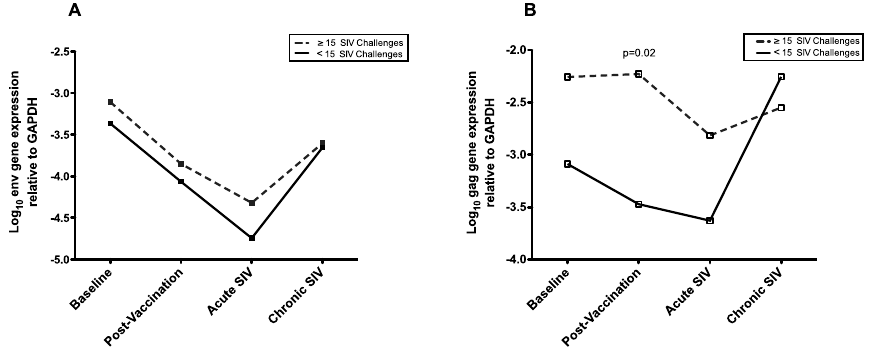
Figure 4. CyERV gene expression is associated with decreased susceptibility to SIV infection. A comparison between animals that required $ 15 challenges with SIV (range: 15–25, mean: 19.2) to become infected versus animals that required , 15 SIV challenges (range: 2–9, mean: 4.9). A) Animals that were less susceptible ( $ 15 SIV challenges) had higher CyERV envelope expression levels at all timepoints. There was no statistically significant difference between the two groups. B) Animals that were less susceptible ( $ 15 SIV challenges) had higher CyERV gag expression levels at baseline, post-vaccination and acute SIV infection. At the post-vaccination timepoint, there was a statistically significant difference between the two groups (p=0.02). Independent-samples t-tests (2-tailed) were performed to determine the statistical significance between groups. Data points represent the mean CyERV values for each group.